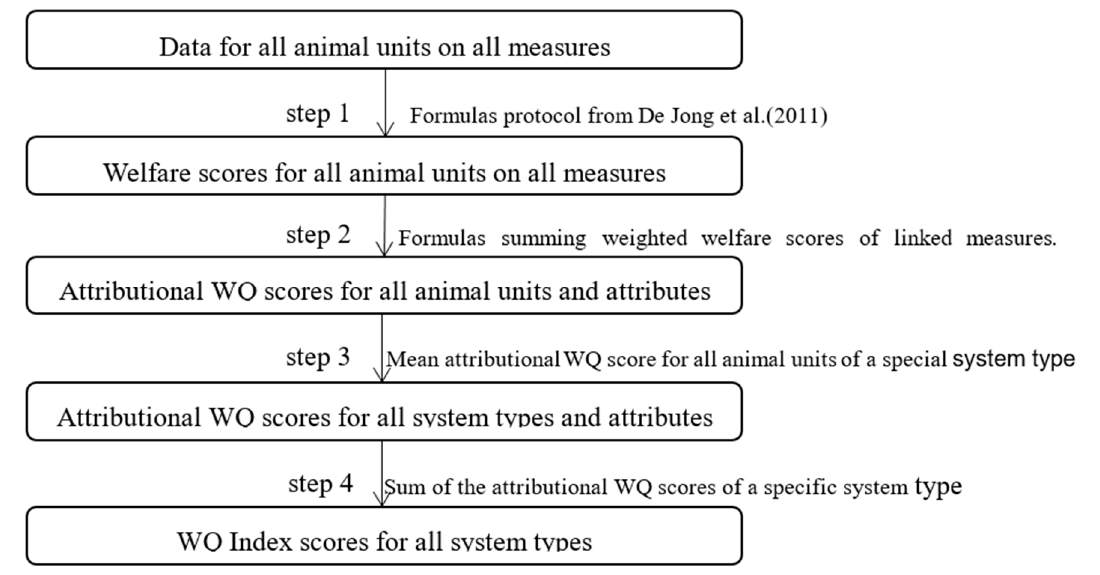
Figure 1. Overview of steps for calculation of the Welfare Quality (WQ) index score.